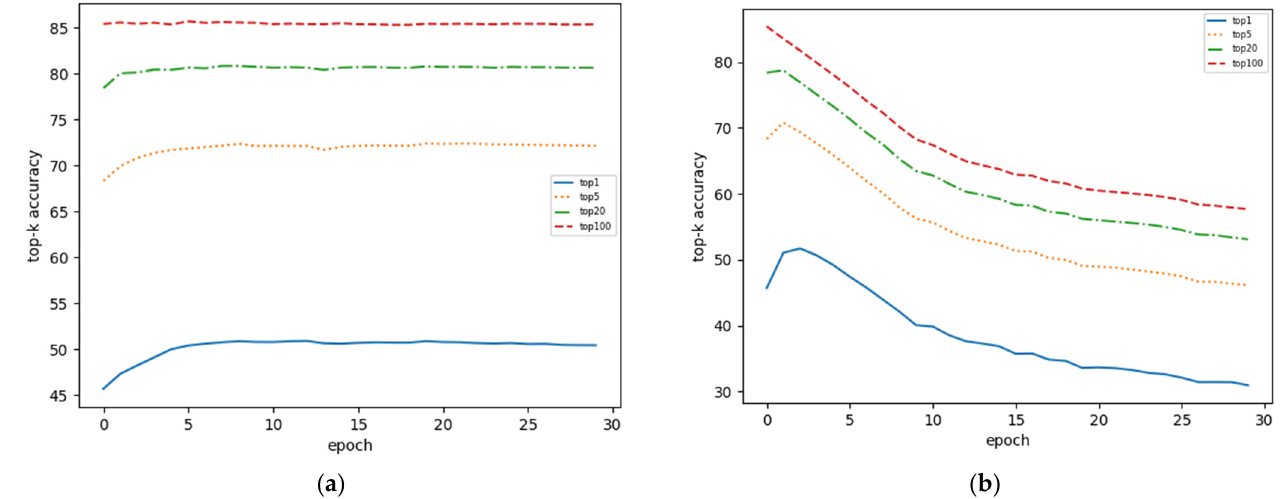
Figure 7. AOpt Retrieval Performance Trends, which are ( a ) passage-centric and ( b )query-centric.